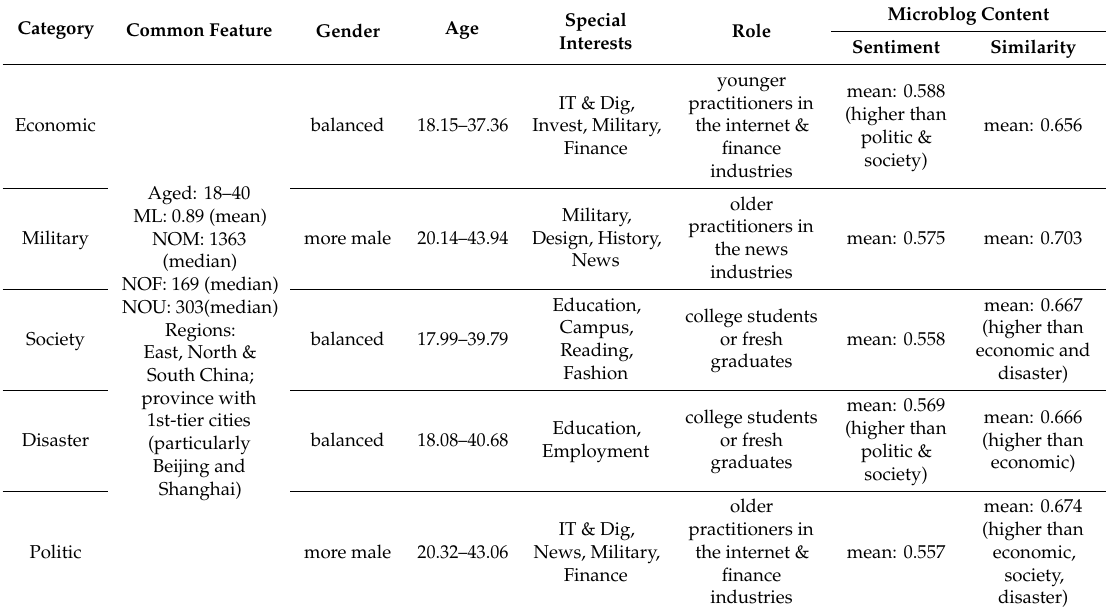
Table 7. General features of the rumor refuters.